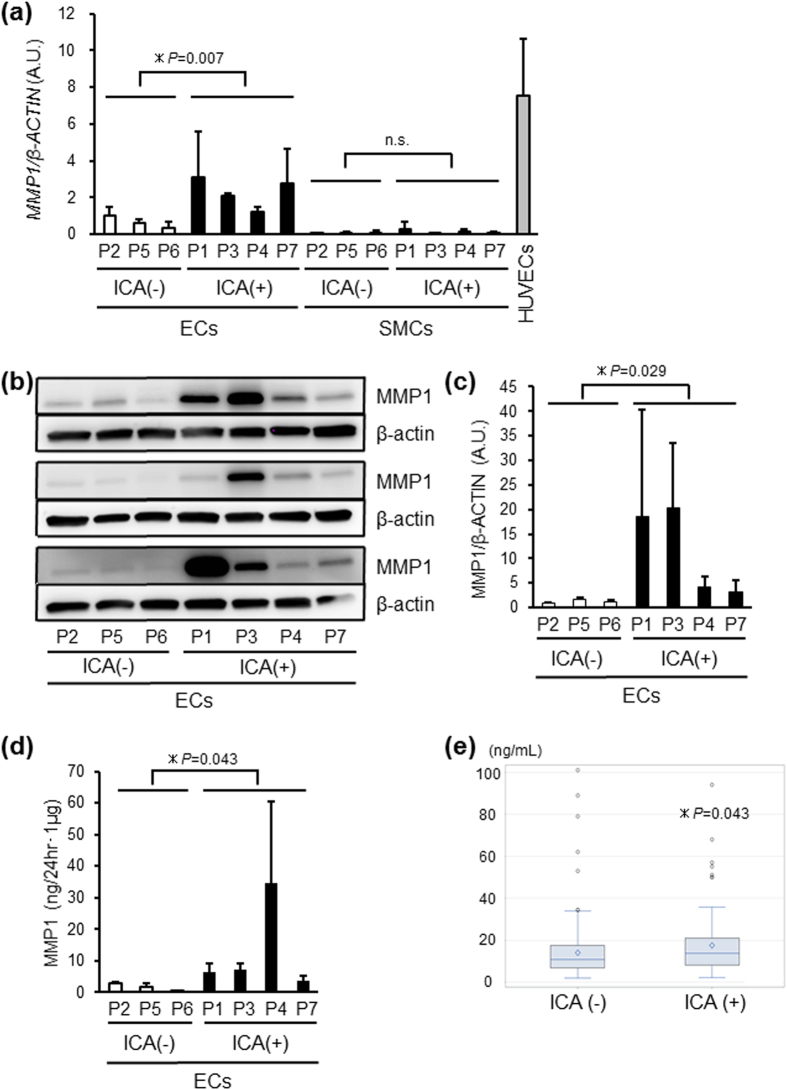
MMP1 Expression is Specifically Upregulated in iPSC-derived Endothelia from ADPKD Patients with ICA.(a) The expression levels of MMP1 in iPSC-derived endothelial cells (ECs) from the four ADPKD patients with intracranial aneurysms (ICAs; P1, P3, P4 and P7) were significantly higher than those from the three patients without ICAs (P2, P5 and P6). Each value was normalized to the average of the iPSC-derived EC samples from P2. (b,c) There was significant upregulation of MMP1 protein expression in iPSC-derived ECs from the four ADPKD patients with ICAs compared to those from the three patients without ICAs, as confirmed by a Western blotting analysis of total cell lysates. Each value was normalized to the average of the iPSC-derived EC samples from P2. (d) The secretion of the MMP1 protein into the culture media from iPSC-derived ECs from the four ADPKD patients with ICAs was significantly higher than those from the three patients without ICAs as assessed by ELISAs. The secreted MMP1 protein level was normalized to the total cellular protein weight of each cell lysate sample from iPSC-derived endothelial cell cultures. (e) A comparison of the serum MMP1 levels from the 97 ADPKD patients with ICAs and the 257 patients without ICAs. The data from three (a,c) and five (d) independent experiments are presented as the means ± SD. SMCs; smooth muscle cells, HUVECs; human umbilical vein endothelial cells, *statistically significant, n.s.; not significant. See also Figures S10, S11, Tables 2 and S6–S9.